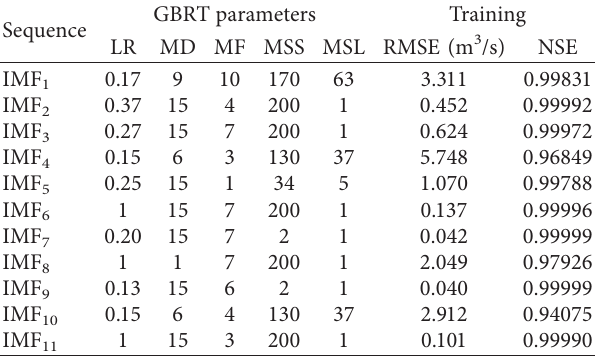
Table 5: Performance of the SVR model during the training period at the Weijiaobao station.